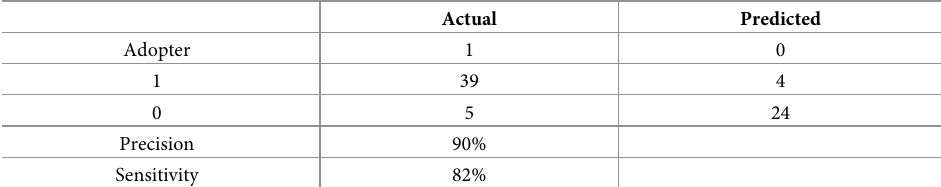
Table 7. Classification matrix to compare the actual vs. predicted